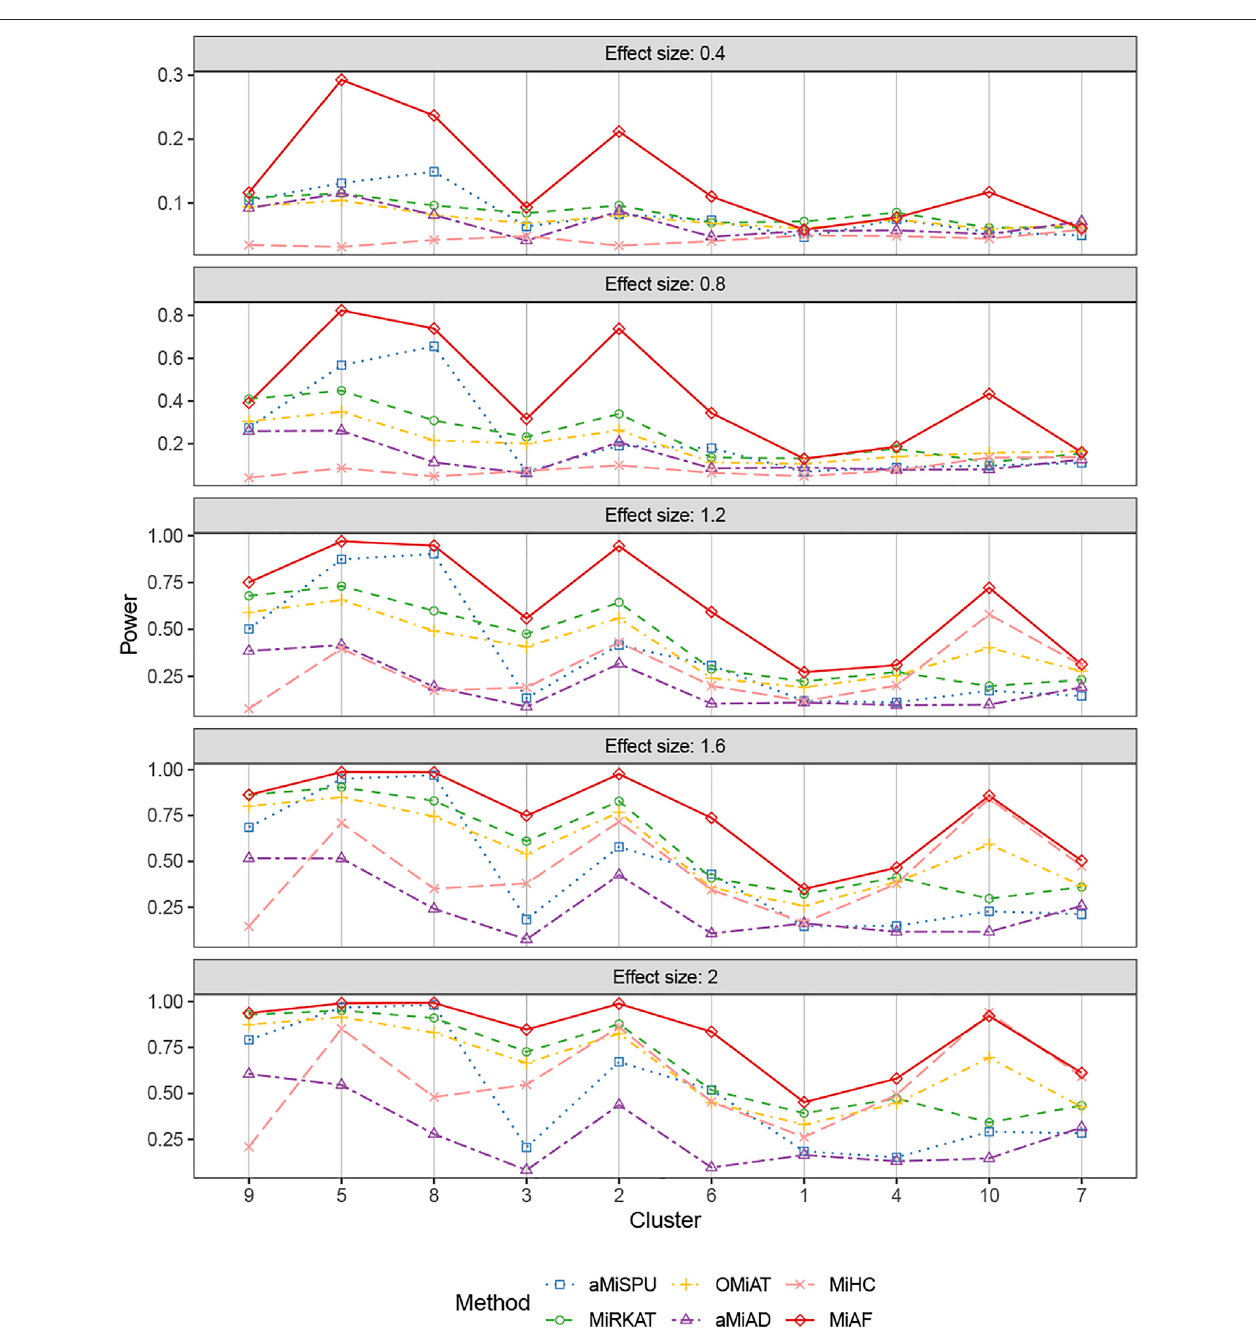
FIGURE5| Powercomparisonforcontinuousoutcomesunderthecorrelatedcaseofscenario2.Atotalof616OTUsweredividedinto10clusters.Thecovariates Z i 2 and OTUs X i · were correlated. The effect size was set as 0.4, 0.8, 1.2, 1.6 and 2. The 10 clusters were sorted by the sum of estimated mean absolute abundance of the OTUs within the cluster that was truly associated from the greatest to the least.